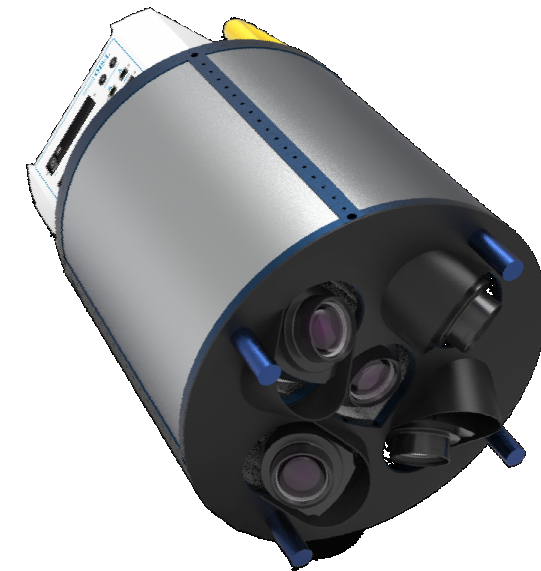
Figure 1: The OIS-L with 550 MPix The sideward looking cameras were mounted in portrait orientation with an tilt angle of 41 degree while the fo ward and backward cameras were mounted with 45 degree tilt angle. This setup results in an oblique GSD of 4.7-7.8 cm. The footprint that is used also for the mission planning is shown in Figure 2.